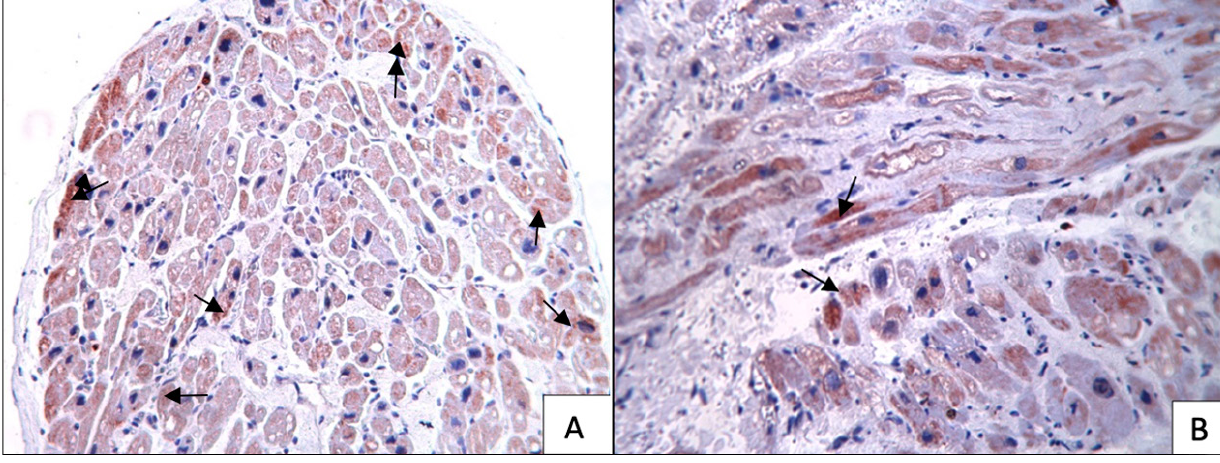
Fig. 4 - eNOS immunostainings of Custodiol versus Blood cardioplegia samples. (A) Custodiol group. Moderate or intense eNOS immunostaining is seen in this section. (B) Blood cardioplegia group. In this section, mild or moderate eNOS immunostaining is seen. Arrows: eNOS stained